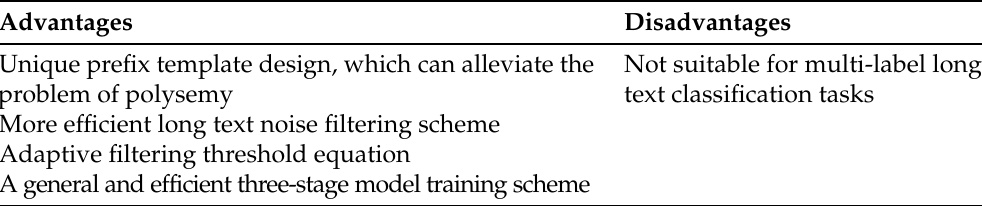
Table 5. Advantages and disadvantages of the LTTA-LE